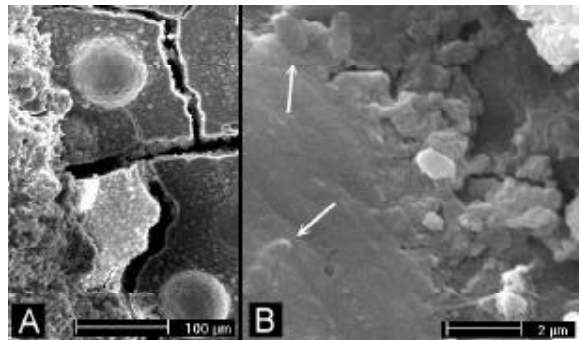
FIGURA 5- grupo 3 – dentes instrumentados: A – superfície plana com estrias paralelas deixadas pela lâmina da cureta (aumento 160X); B – Smear layer (aumento